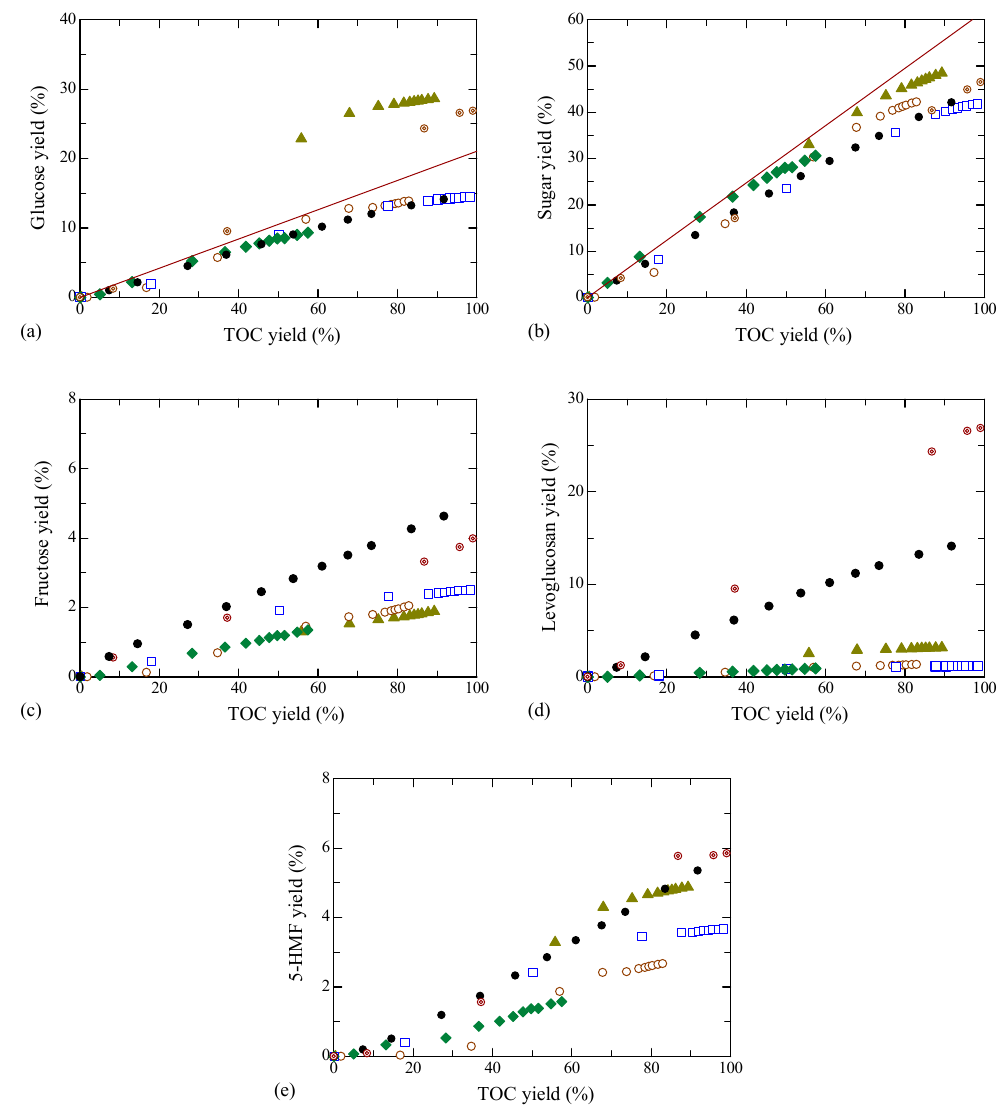
Figure 5. Relationship between product and TOC yields. ( a ) Glucose, ( b ) sugar, ( c ) fructose, ( d ) levoglucosan, and ( e ) 5-HMF yield. The data and key are the same as in Figure 1.